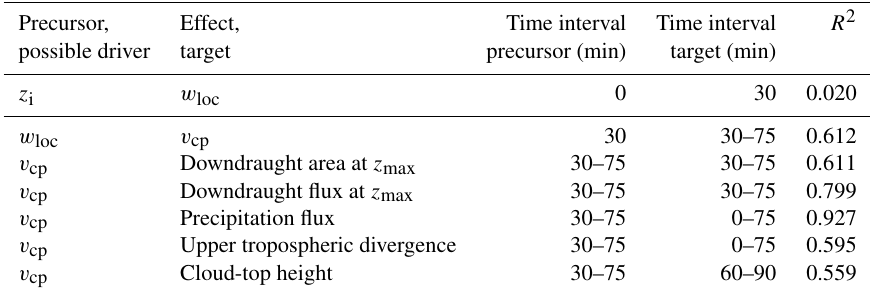
Precursor, Effect, Time